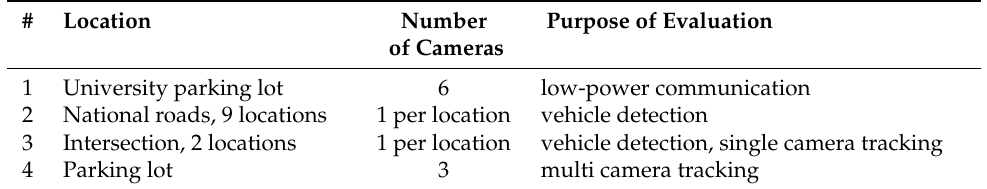
Table 2. Summary of the pilot